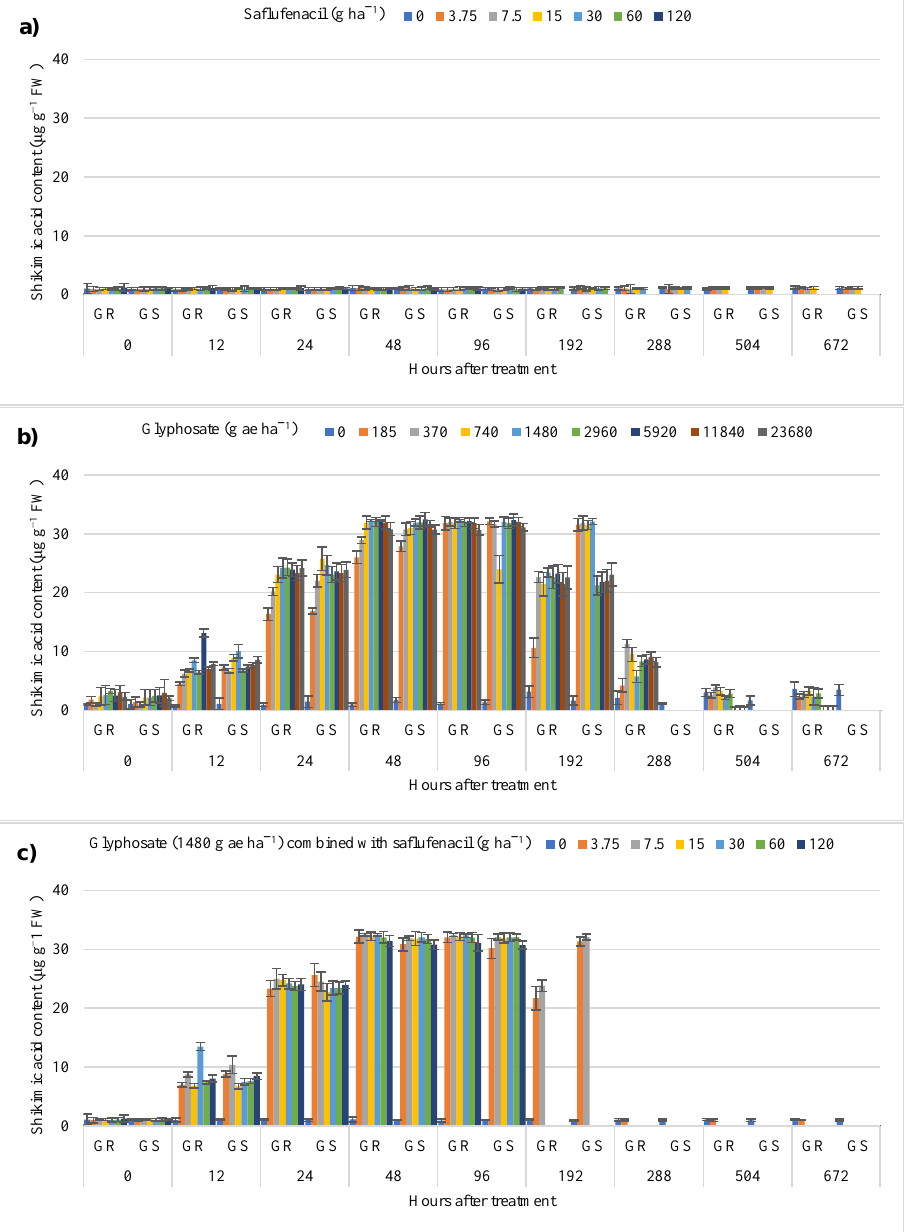
Figure 3. Time-course results of shikimic acid content in glyphosate-resistant (GR) and -sensitive (GS) Conyza bonariensis biotypes in response to treatment with (a) saflufenacil (0, 3.75, 7.5, 15, 30, 60, and 120 g ha −1 ), (b) glyphosate (0, 185, 370, 740, 1480, 2960, 5920, 11,840, and 23,680 g ae ha −1 ), and (c) glyphosate (1480 g ae ha −1 ) combined with saflufenacil rates (0, 3.75, 7.5, 15, 30, 60, and 120 g ha −1 ). The interval bars represent 95% confidence intervals (CI). Individual comparisons between biotypes for each respective herbicide rate and time after treatments are presented in Tables S1–S3. Regressions are presented in Tables S4–S6.